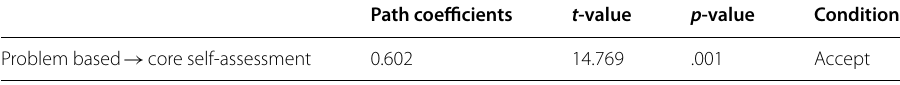
Significant at the level of 0.01 ( p < 0.01)